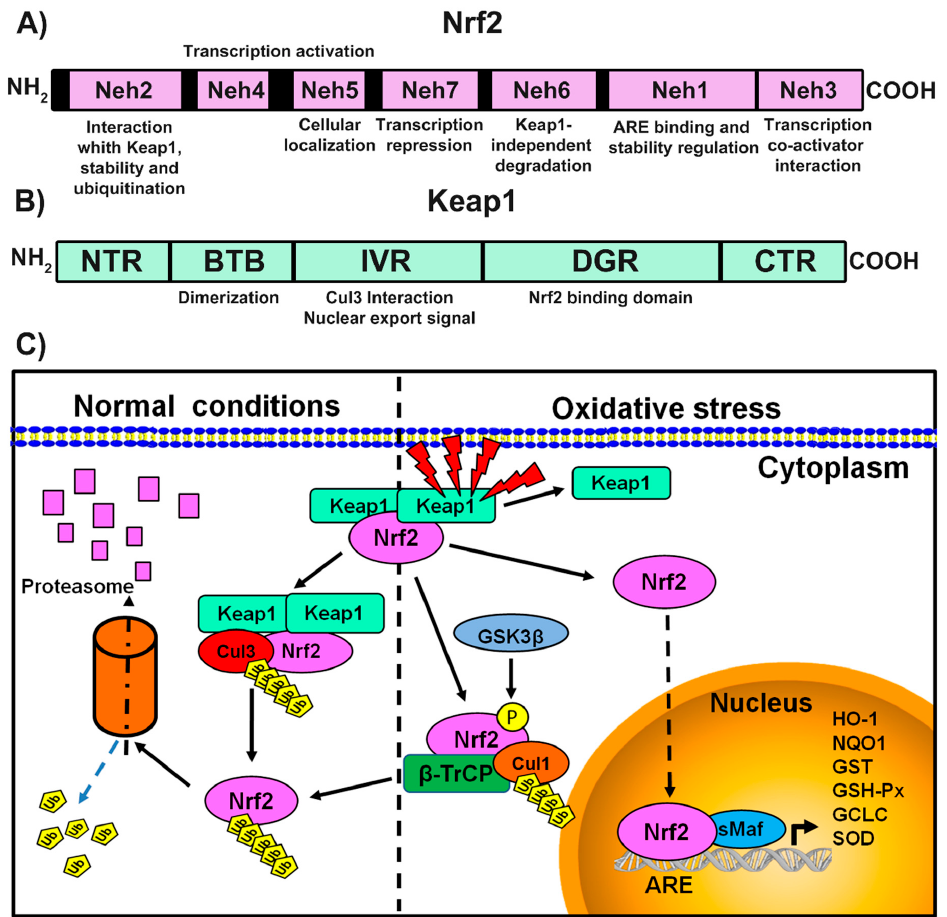
Figure 1 . Schematic representation of the primary structure of Nrf2 ( A ) and Keap1 ( B ) domains and their respective functions. ( C ) Representation of regulatory mechanisms in Keap1/Nrf2 signaling. In normal conditions, Nrf2 remains inactive bound to its endogenous inhibitor Keap1; this heterodimer binds the Cul3-Rbx E3 ubiquitin ligase complex that triggers Nrf2 degradation by the proteasome. Under oxidative stress conditions, Nrf2 is released from Keap1 and translocates to the nucleus, forming a heterodimer with sMaf. Nrf2-sMaf heterodimers bind to ARE sequences promoting the expression of antioxidant genes. Alternatively, when Nrf2 is phosphorylated by GSK-3, β -TrCP mediates its interaction with a Cul1 ubiquitin ligase complex (Skp1-Cul1-Rbx1 / Roc1) to promote the proteasomal degradation of Nrf2, thus inhibiting the expression of cytoprotective